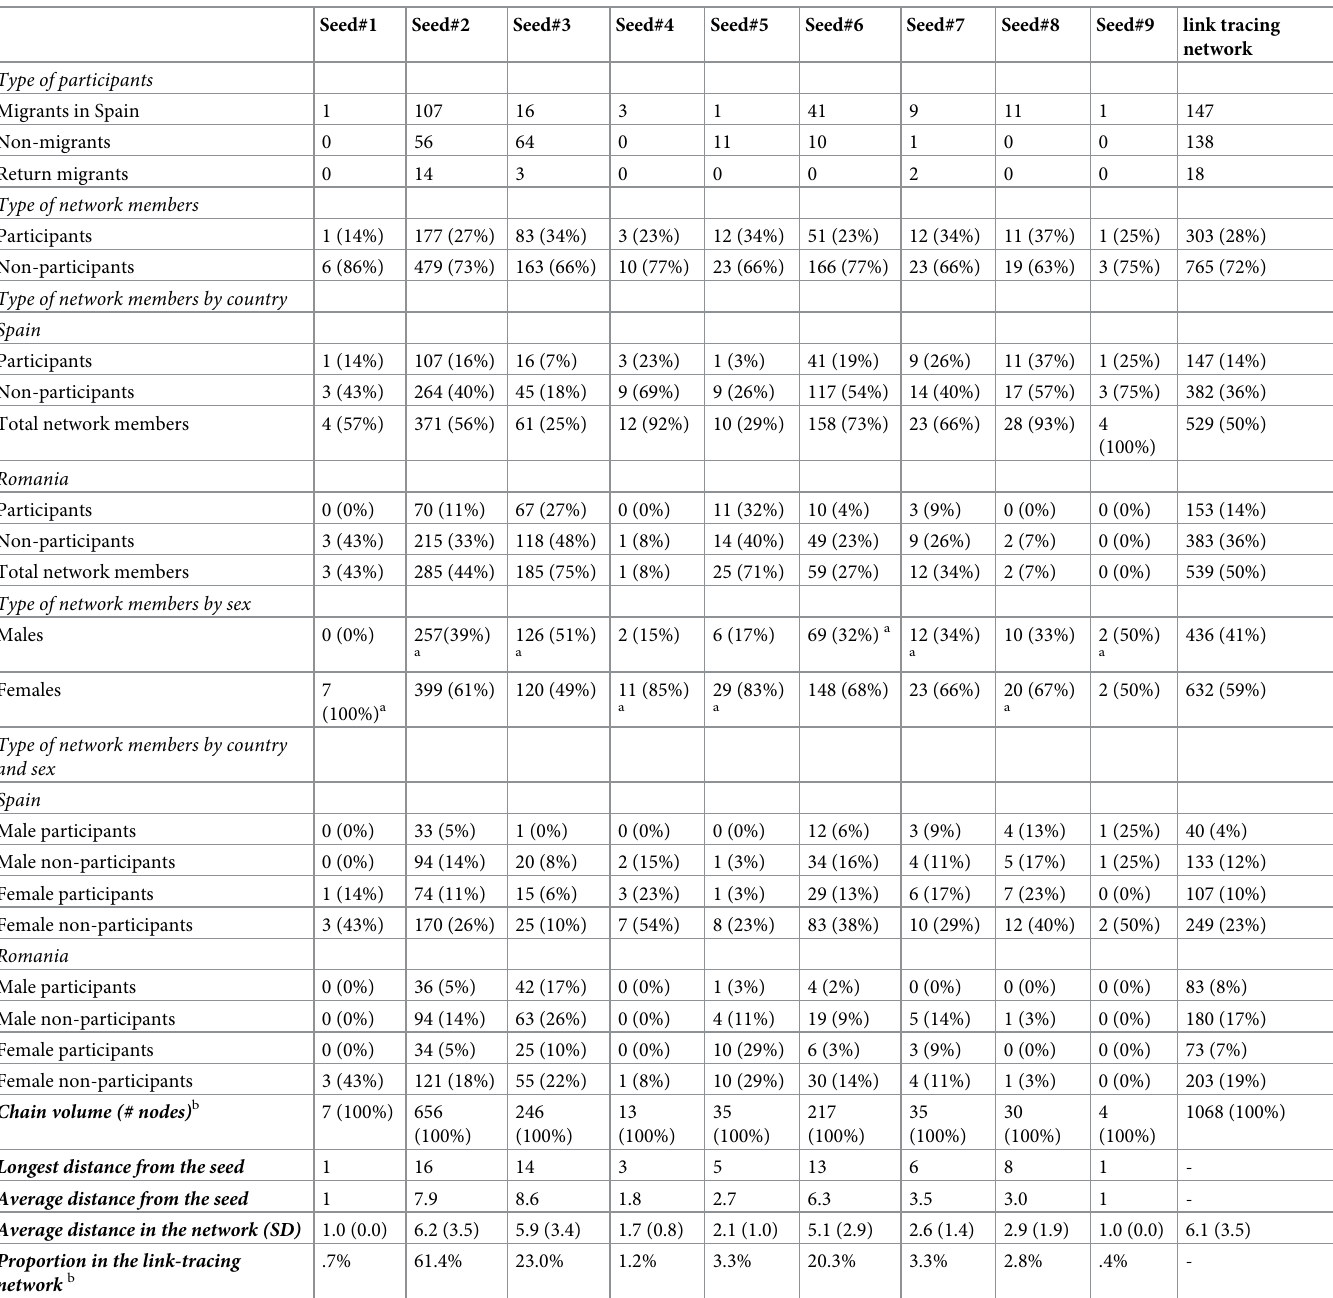
Table 7. The demographic composition of the link-tracing network